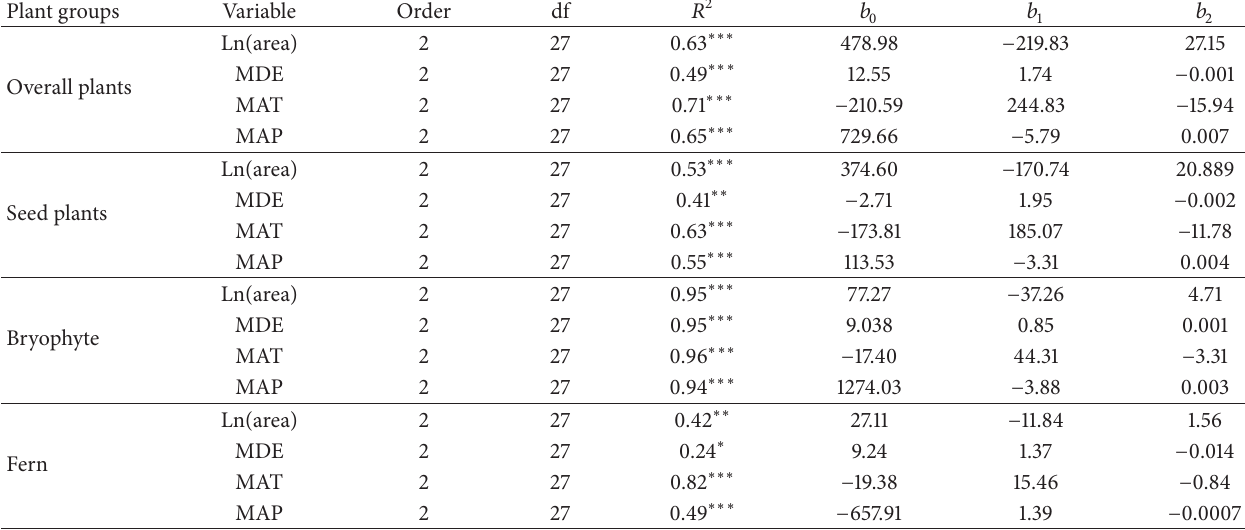
Table 3: Series of second-order polynomial regressions for species richness and predictor variables. Plant groups Overall